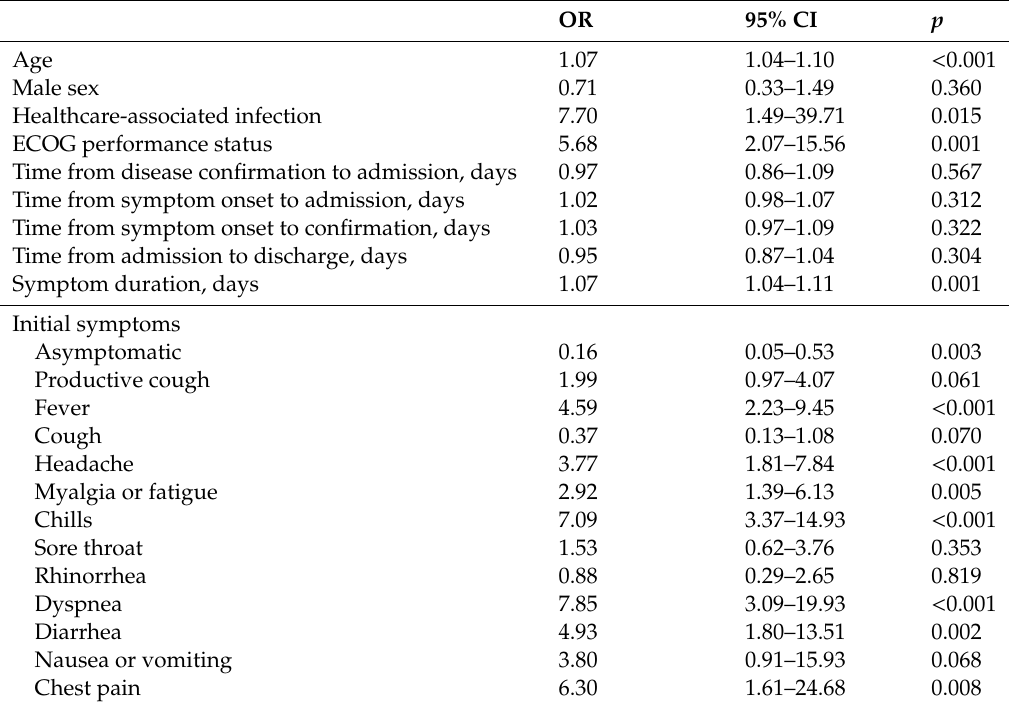
Table A1. Logistic regression of risk factors for COVID-19 disease progression